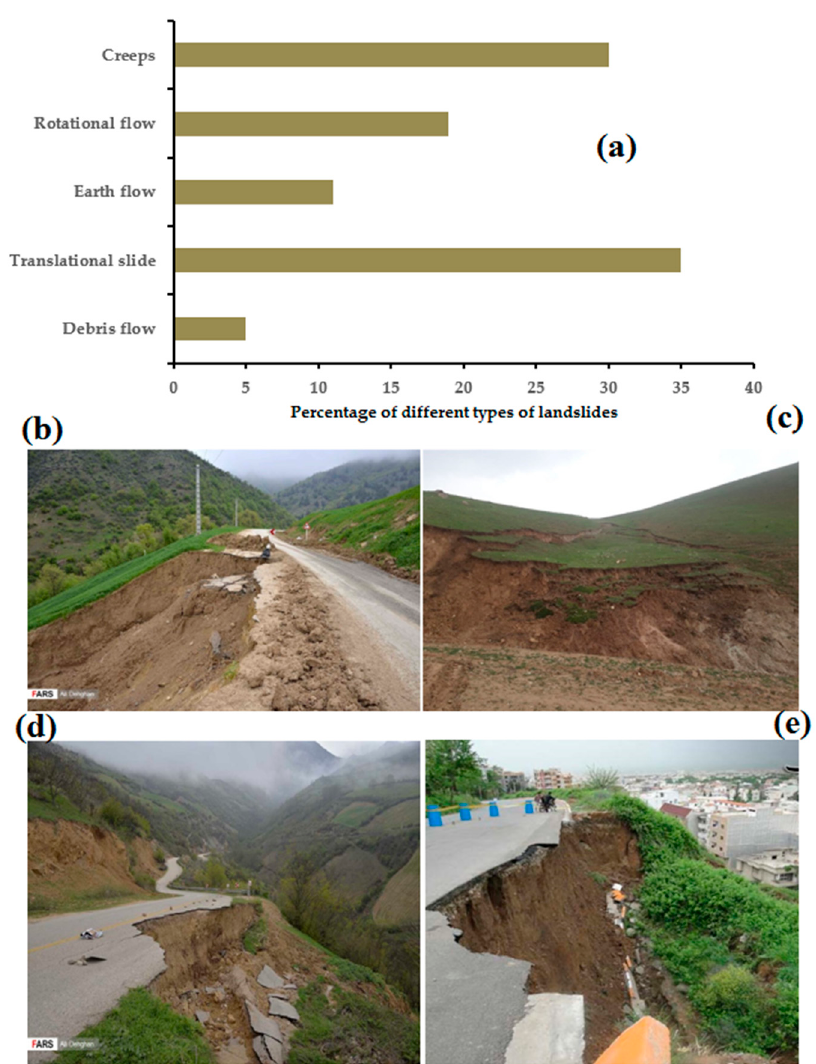
Figure 3. ( a ) Distribution of different landslide types; ( b – e ) examples of landslides in the study area (Farsnews, 2019 and field survey).